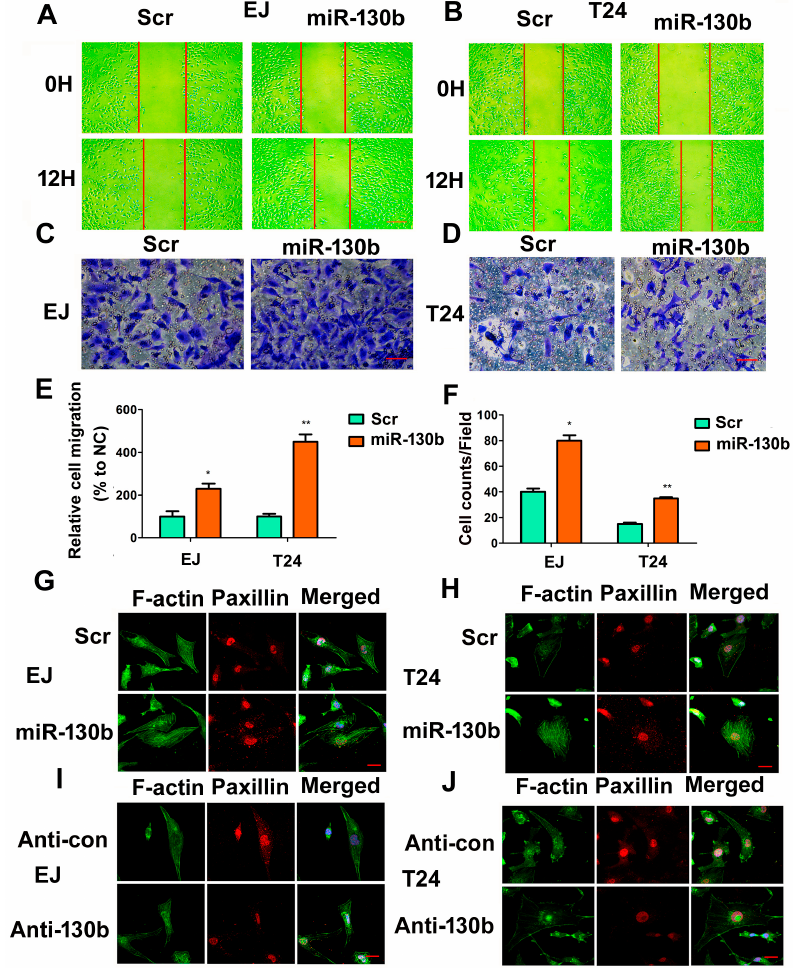
Figure 7. miR-130b-3p promotes cell migration and invasion capability. ( A , B ) Wound healing assay of EJ and T24 cells transfected with miR-130b-3p mimics or the scramble control at 0 and 12 h respectively. Scale bar = 200 μ m; The red lines are the scratch position; ( C , D ) Transwell assay. Scale bar = 100 μ m; ( E ) Quantitative wound assay data. Data are the mean ± SD of wound width in three experiments. * p < 0.05, ** p < 0.01; ( F ) Quantitative transwell assay data. Data are the mean ± SD of invaded cell counts in five fields. * p < 0.05, ** p < 0.01; and ( G – J ) Phalloidine-fluorescein isothiocyanate (FITC) staining of microfilament ( green ) and skeleton molecule paxillin ( red ) under confocal laser scanning microscopy. Scale bar = 20 μ m.